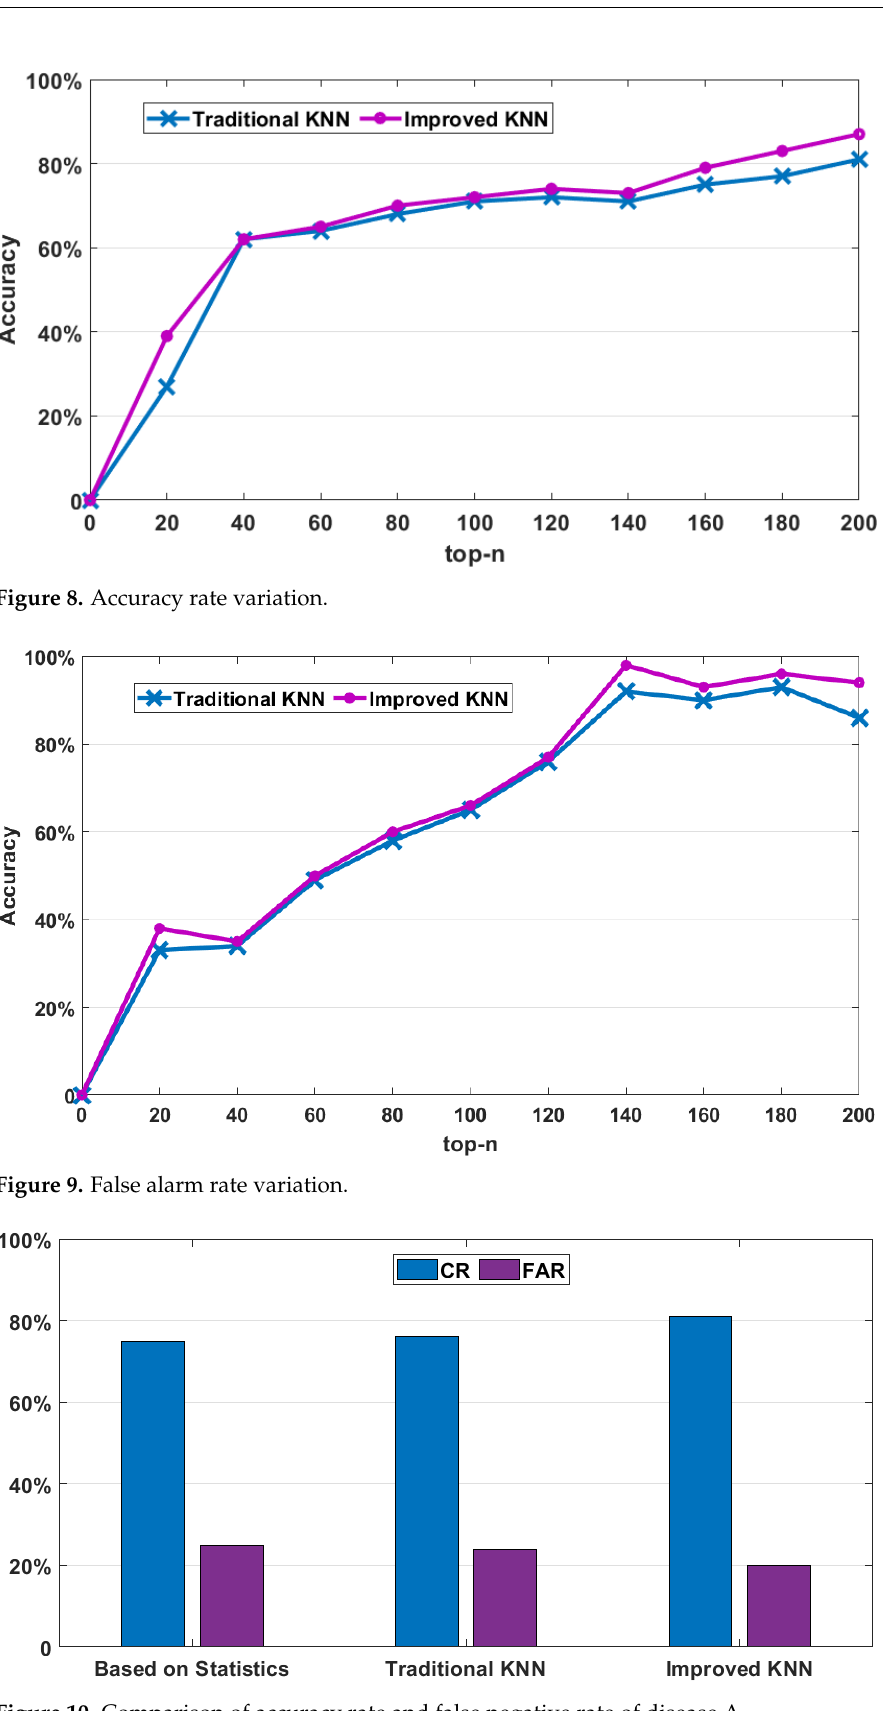
Figure 10. Comparison of accuracy rate and false negative rate of disease